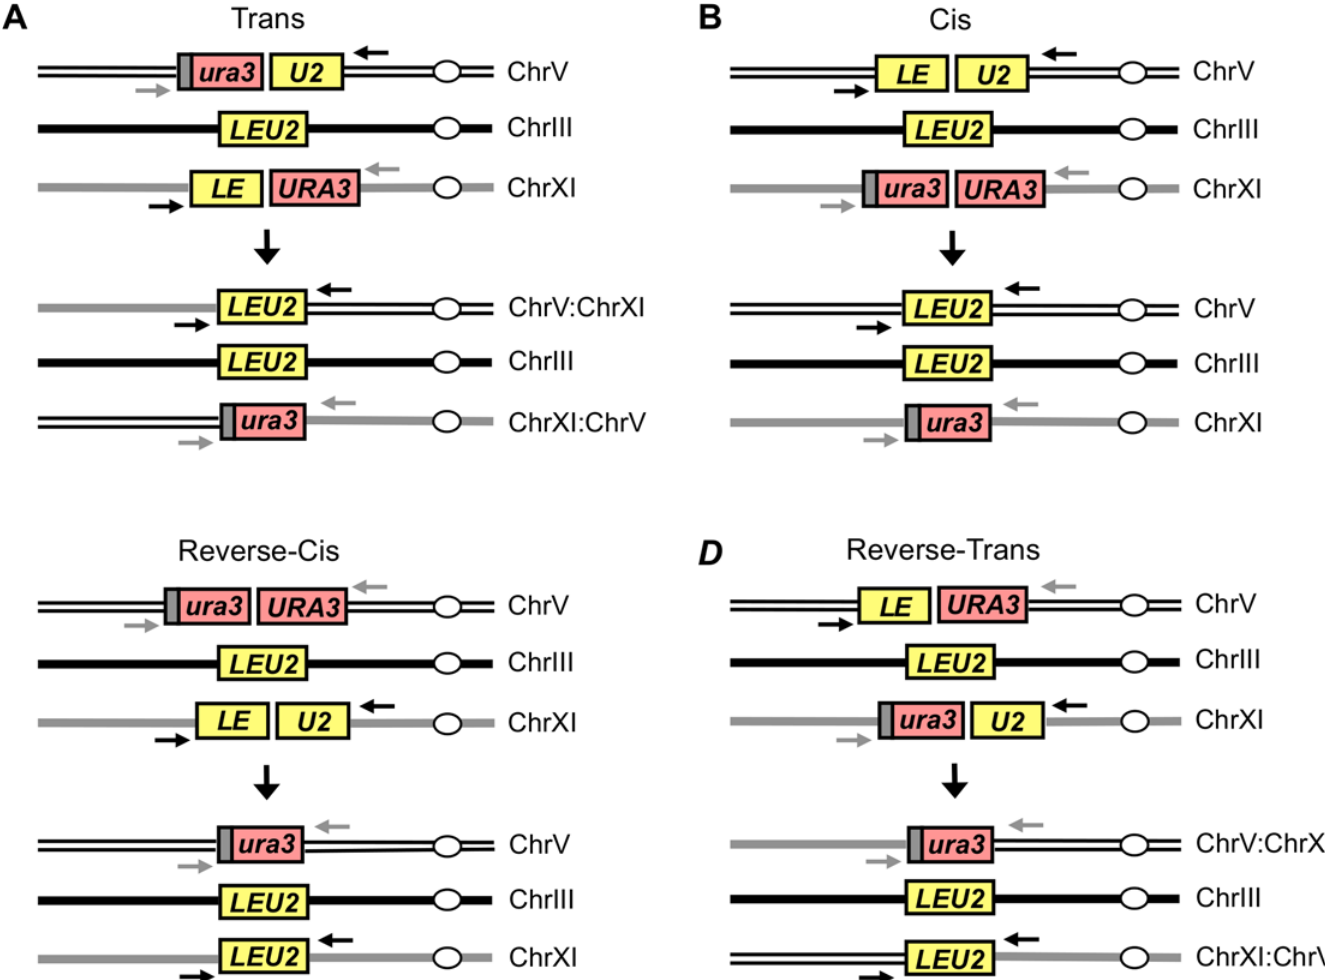
Fig 1. Schematic representation of the strains used to study repair in different configurations. (A) Schematic of the strain used to study repair in Trans (strain YSJ379). A 5 ’ truncated ura3-HOcs-U2 cassette is present at the can1 locus on the left arm of Chr V, a LEU2 donor is present distal to the YCL048W-A locus on the left arm of Chr III and an LE-HOcs-URA3 cassette is present distal to the BUD2 locus on the left arm of Chr XI. Bottom panel indicates the repair outcome in which the LE end from the break on Chr XI and the U2 end from the break on Chr V are repaired by GC (using the LEU2 donor on Chr III), and the ura3 end from the break on Chr V and the URA3 end from the break on Chr XI are repaired by interchromosomal SSA resulting in deletion of one of the URA3 repeats. Both repair events in the Trans strain are associated with a reciprocal translocation between chromosomes V and XI. (B) Schematic of the strain used to study repair in Cis (YSJ357). Bottom panel indicates the repair outcome in which the HO break within leu2 on Chr V is repaired by GC (using the LEU2 donor on Chr III), and the HO break on Chr XI is repaired by intrachromosomal SSA resulting in deletion of one of the URA3 repeats. (C) Schematic of the Reverse-Cis strain (tNS2614) in which the positions of the LE-HOcs-U2 and ura3-HOcs-URA3 cassettes have been reversed relative to the Cis arrangement. The HO break within leu2 on Chr XI is repaired by GC (using the LEU2 donor on Chr III), and the HO break on Chr V is repaired by intrachromosomal SSA resulting in deletion of one of the URA3 repeats. (D) Schematic of the Reverse-Trans strain (tNS2638) in which the positions of the 5 ’ truncated ura3-HOcs-U2 cassette and the LE-HOcs-URA3 cassette are switched relative to the Trans strain. Bottom panel indicates the repair outcome in which the LE end from the break on Chr V and the U2 end from the break on Chr XI are repaired by GC (using the LEU2 donor on Chr III), and the ura3 end from the break on Chr XI and the URA3 end from the break on Chr V are repaired by interchromosomal SSA resulting in deletion of one of the URA3 repeats. Both repair events in this strain are also associated with a reciprocal translocation between chromosomes V and XI. Black arrows indicate the positions of the PCR primers used to study the kinetics of LEU2 repair while the gray arrows indicate the position of primers used to examine the SSA